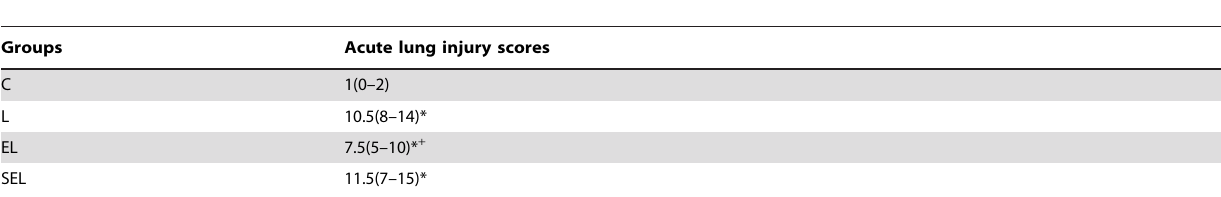
Values were expressed as medians (range). The lung injury was scored by a 5-point scale according to combined assessments of alveolar congestion, hemorrhage and edema, infiltration or aggregation of neutrophils in the airspace or vessel wall and thickness of alveolar wall/hyaline membrane formation: Score of 0=minimal (little) damage; 1 + =mild damage; 2 + =moderate damage; 3 + =severe damage; and 4 + =maximal damage. Minimum and maximum possible lung injury scores are 0 and 16, respectively. *P , 0.05 versus Group C; + P , 0.05 versus Group